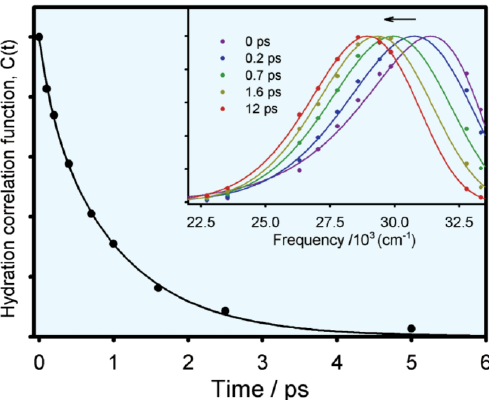
Figure 5. Solvent response function of tryptophan in aqueous solution (excitation: 288 nm). The insert is the normalized spectral evolution at five different decay points. Image reproduced from Journal of Physical Chemistry B 106 (2002) 12376.